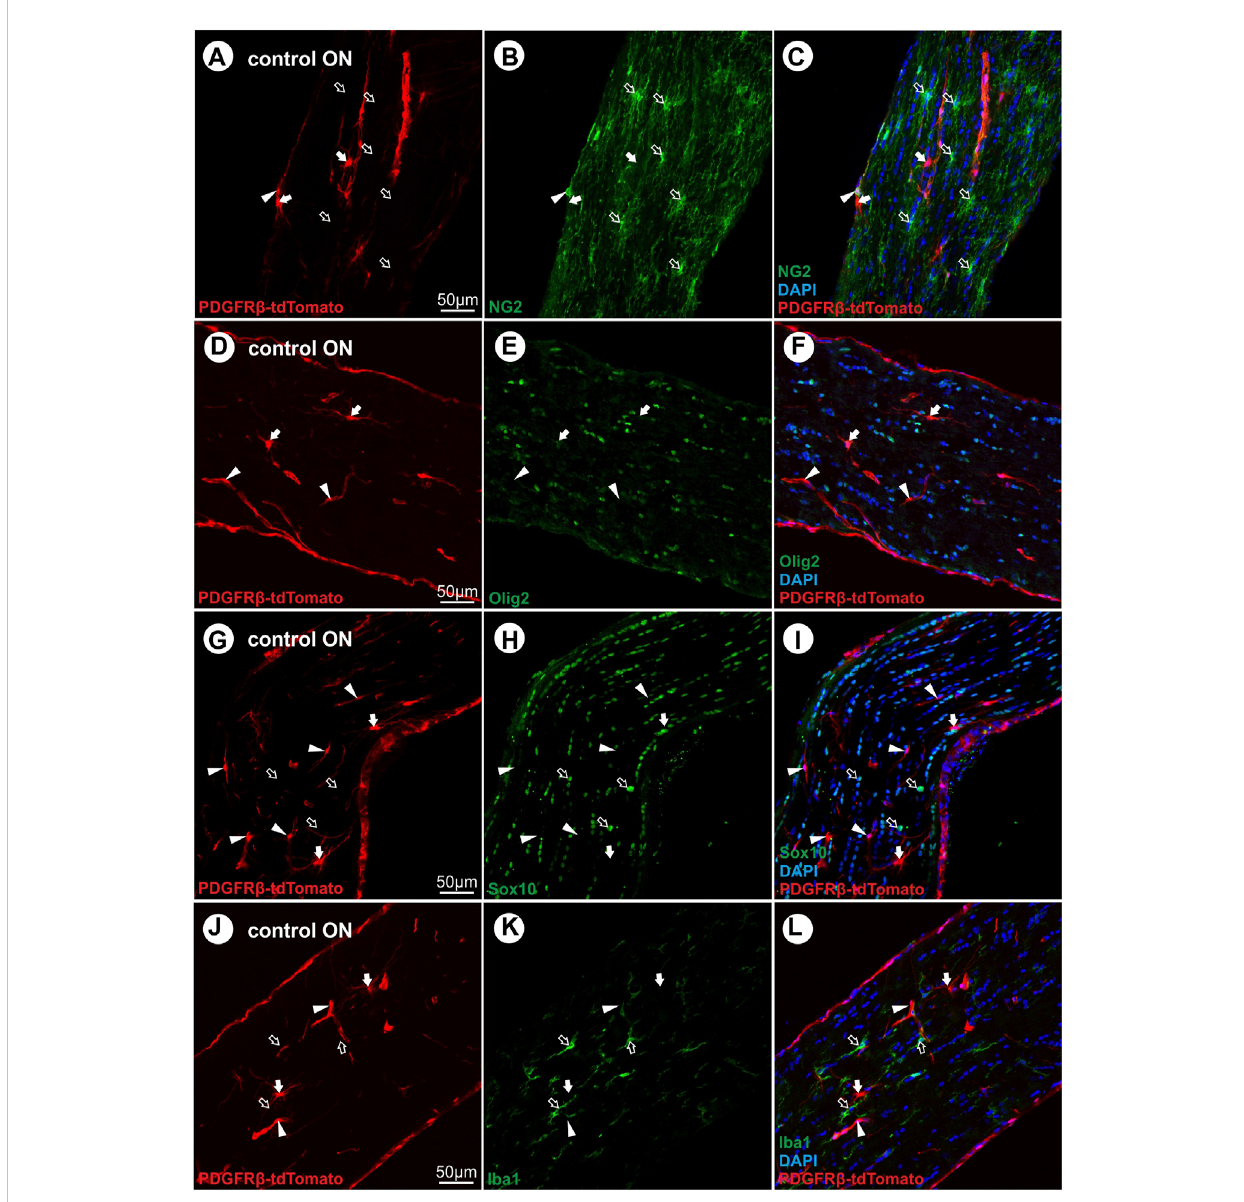
FIGURE 2 Characterizationofnon-vascularbranchedPDGFR β -tdTomato + cellswitholigodendroglial(NG2,Olig2,Sox10)andmicroglial (Iba1)markers. (A – C) Non-vascular branched tdTomato + cells (red) revealed no co-localization with NG2 (green), an oligodendroglial as well as PC marker. (D – F) No co- localization was observed for non-vascular and vascular tdTomato + cells with Olig2 (green). (G – I) The non-vascular tdTomato + cells further lacked Sox10-IR (green) and (J – L) revealed no co-localization with the microglial marker Iba1 (green). Filled arrows show non-vascular tdTomato + cells, fi lled arrowheads show vascular tdTomato + cells, and blank arrows show cells with IR for oligodendroglial or microglial